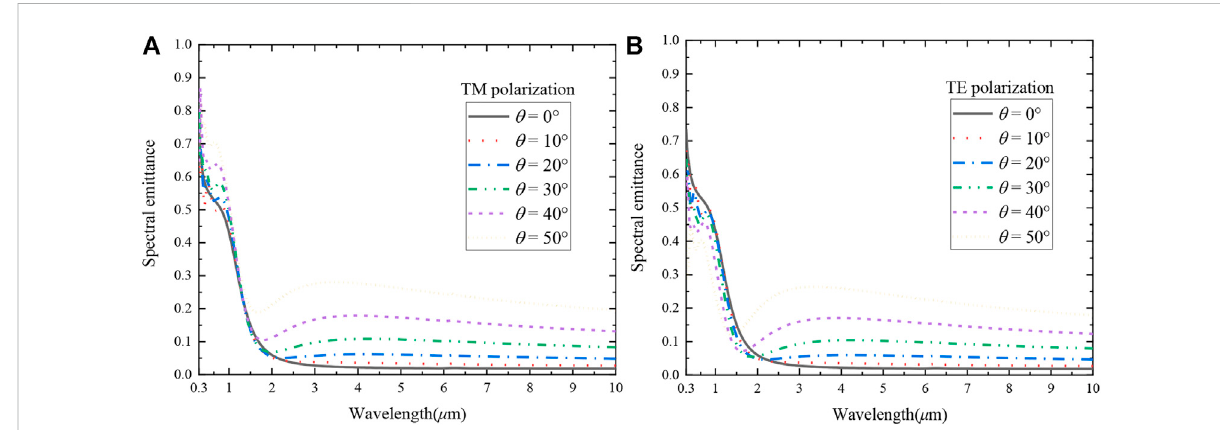
FIGURE 12 Variation of spectral emittance with incident angle for two-dimensional Mo structures ( r = 60 nm, a = 150 nm, h = 900 nm, n c = 1) for (A) TM polarization and (B) TE polarization, respectively.